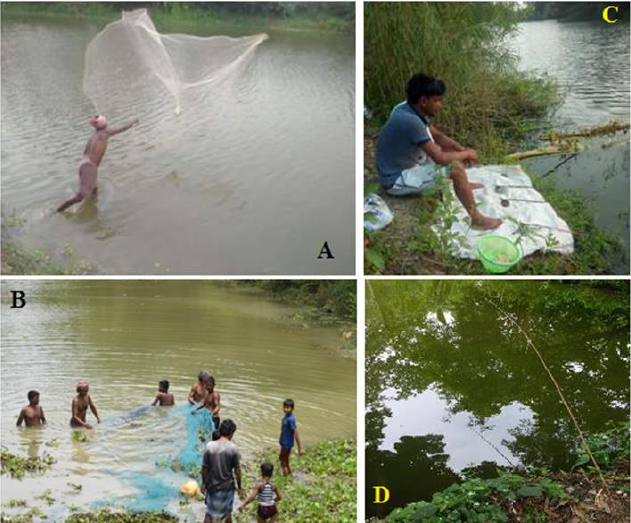
Figure 2: Different types of traditional fishing methods used for fishing Attu fish. ( A ) Hand throwing net, ( B ) Fishing reel and rod, ( C ) Current netting and ( D ) Tanga